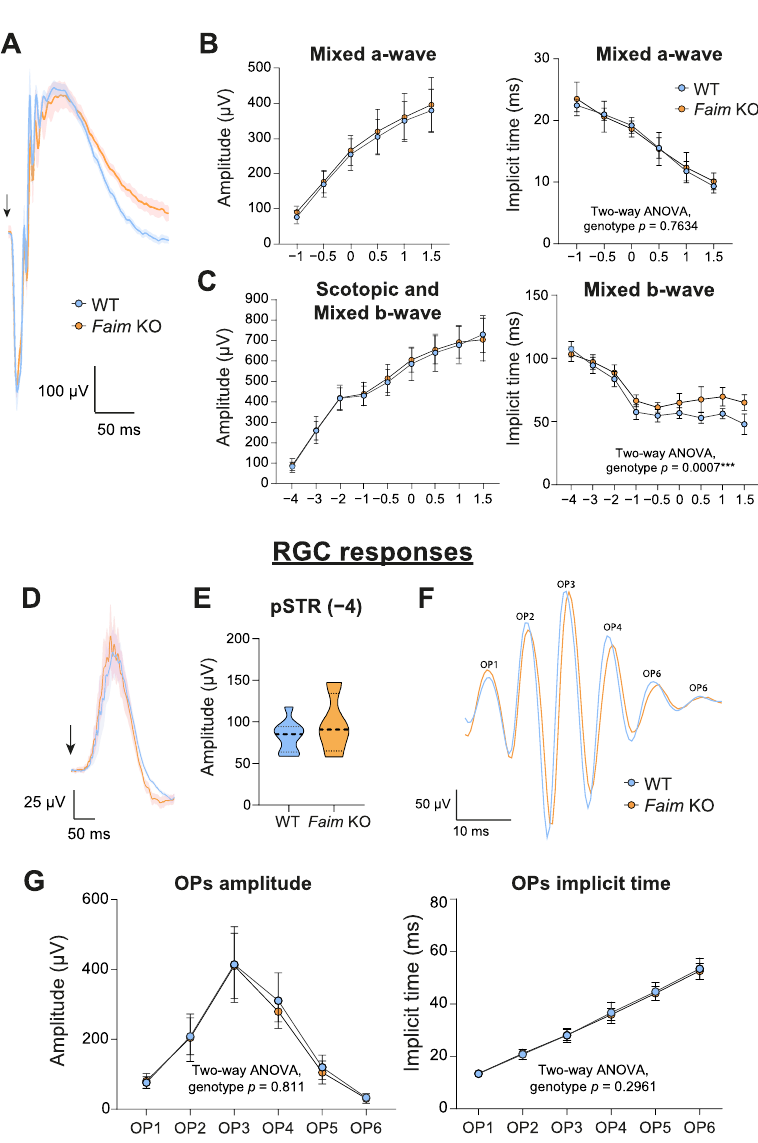
Figure 2. Faim KO mice ERG analyses are not altered at three months of age. ( A ) ERG recordings at 1.5 log cd·s/m 2 plotted as the mean (solid line) and SEM deviation (shaded area) of each condition. ( B ) a-wave amplitude and implicit time at 1.5 log cd·s/m 2 . ( C ) b-wave amplitude and implicit time at 1.5 log cd·s/m 2 . ( D ) ERG waves of pSTR responses at − 4 log cd·s/m 2 plotted as the mean (solid line) and SEM deviation (shaded area) of each condition. ( E ) pSTR amplitudes represented in violin